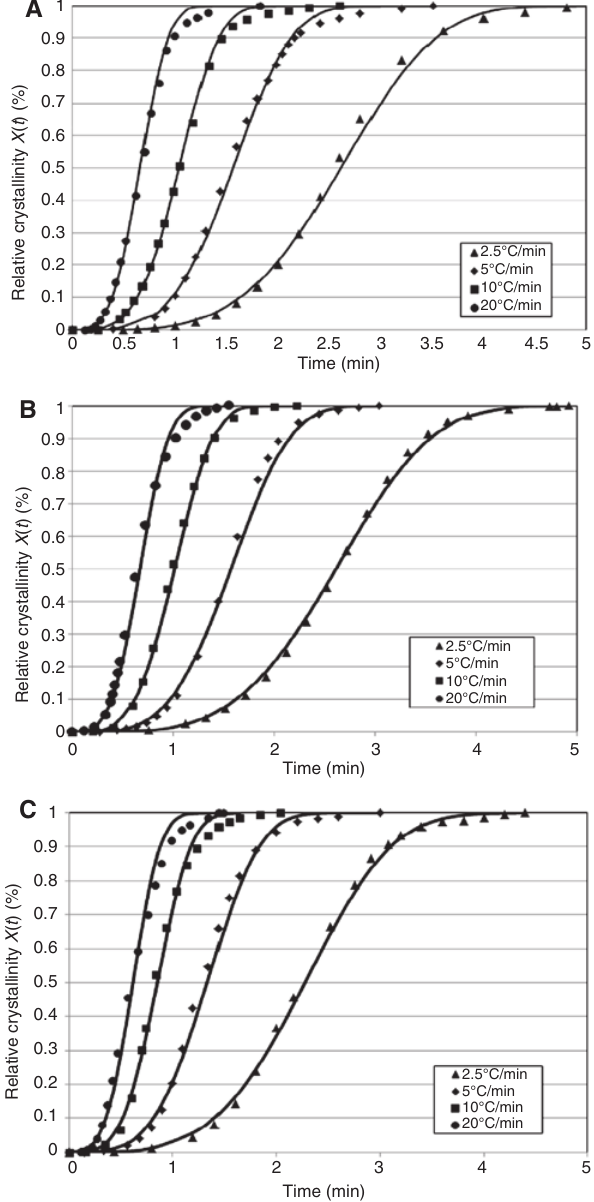
Figure 3: Variation of the relative crystallinity with time for non- isothermal crystallization of (A) neat polypropylene (PP), (B) PP-25 date palm fiber (DPF)-5MA and (C) PP-50DPF-5MA composite materi- als at different cooling